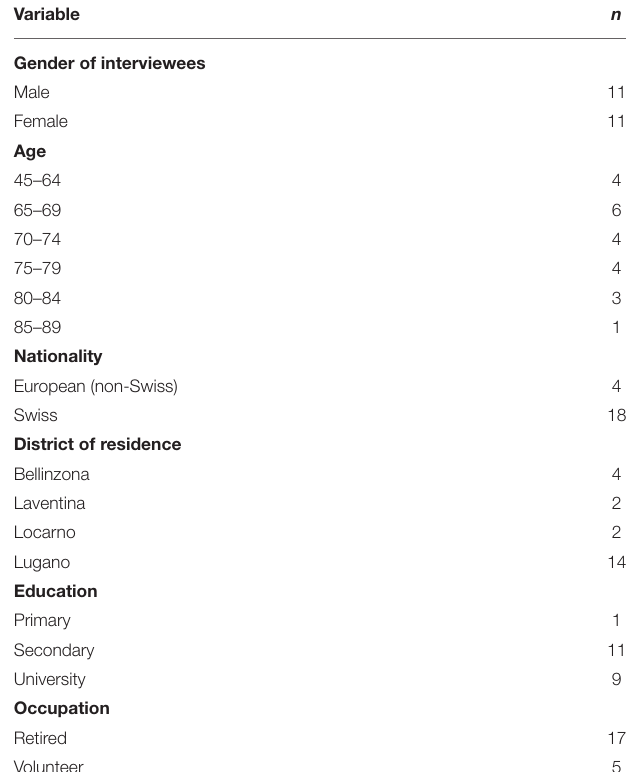
TABLE 1 | Study participants ( N =